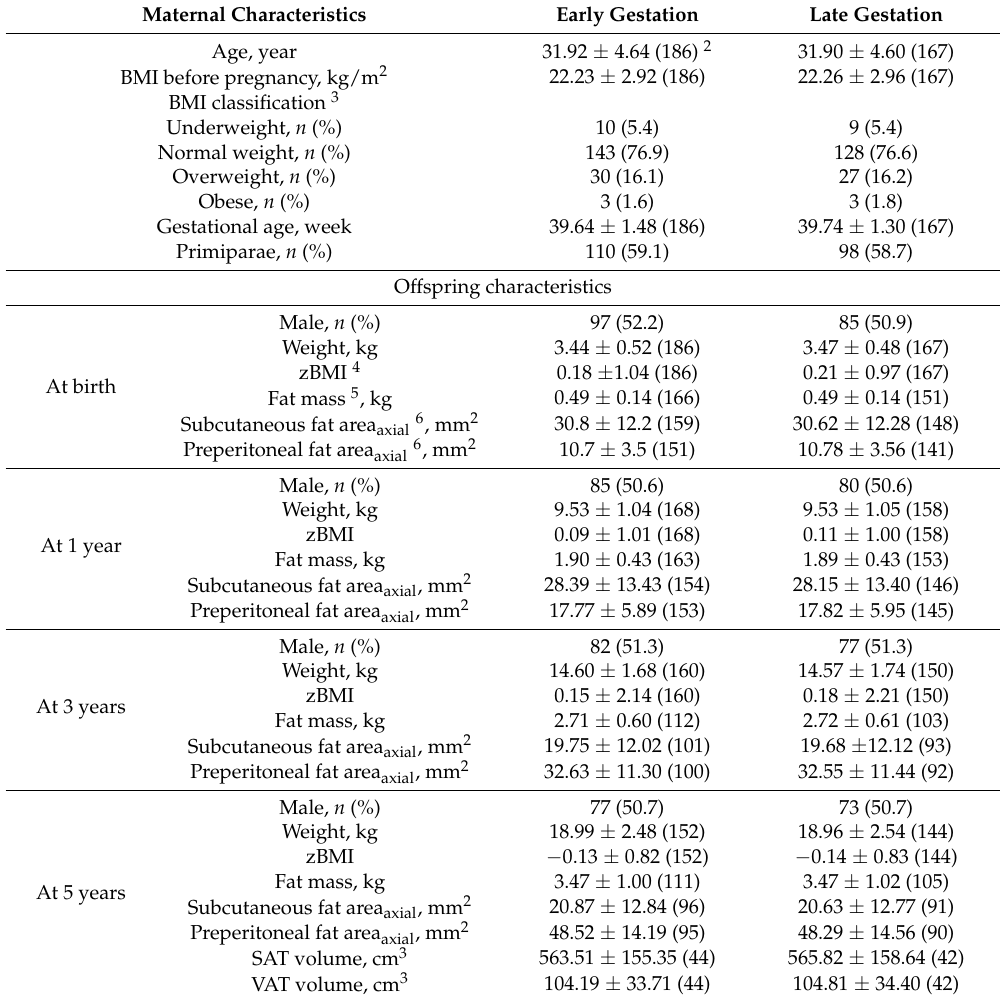
Table 1. Characteristics of mother-child pairs at early and late gestation 1